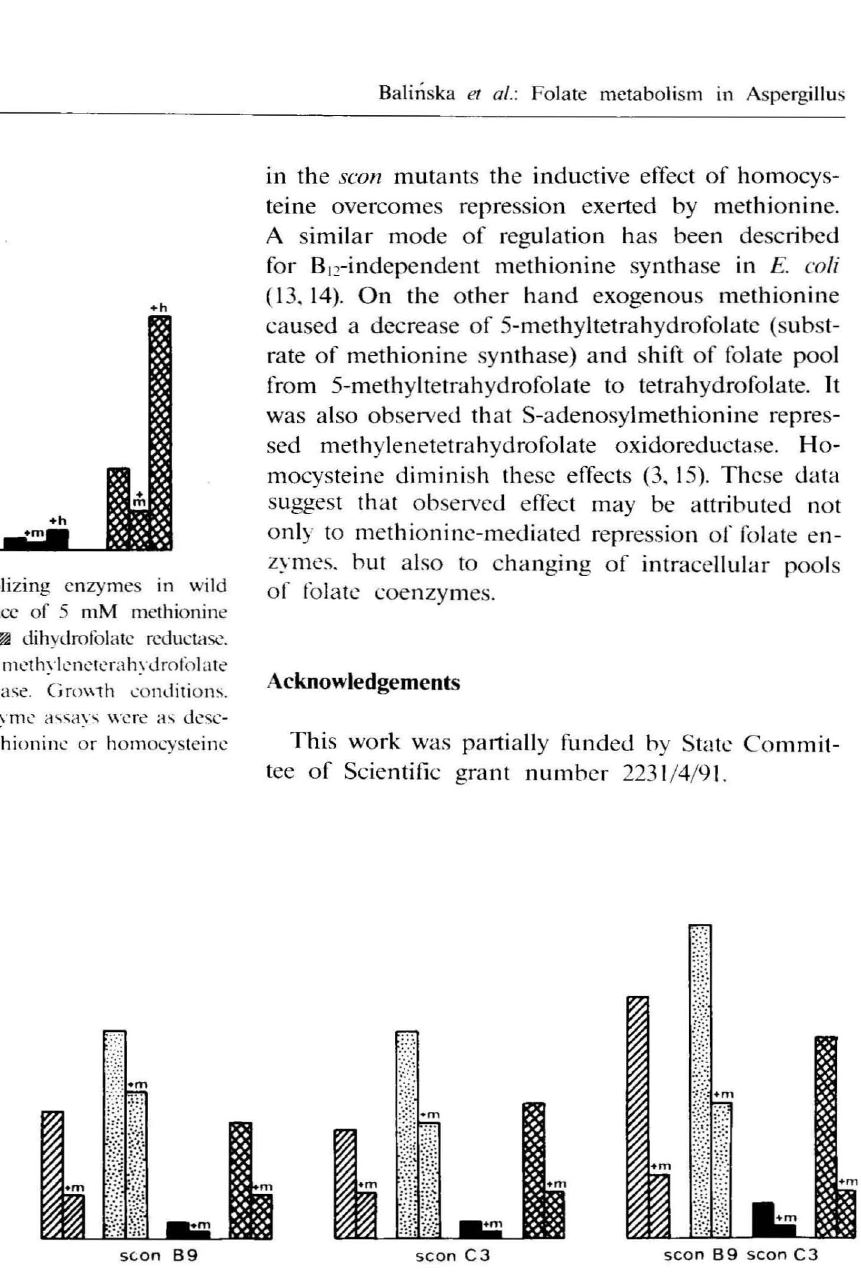
Figure 3. Activity of folate metabolizing enzymes in scon strains cultured in absence and presence of 5 mM methionine (+ m). Ii!! dihydrofolate reductase. H serine hydroxymethyltransferase . • methyleneterahydrofolate oxidoreductase. a methionine synthase. Growth conditions. mycelial extract preparation and enzyme assays as described in Materials and methods. Methionine was added at the start of